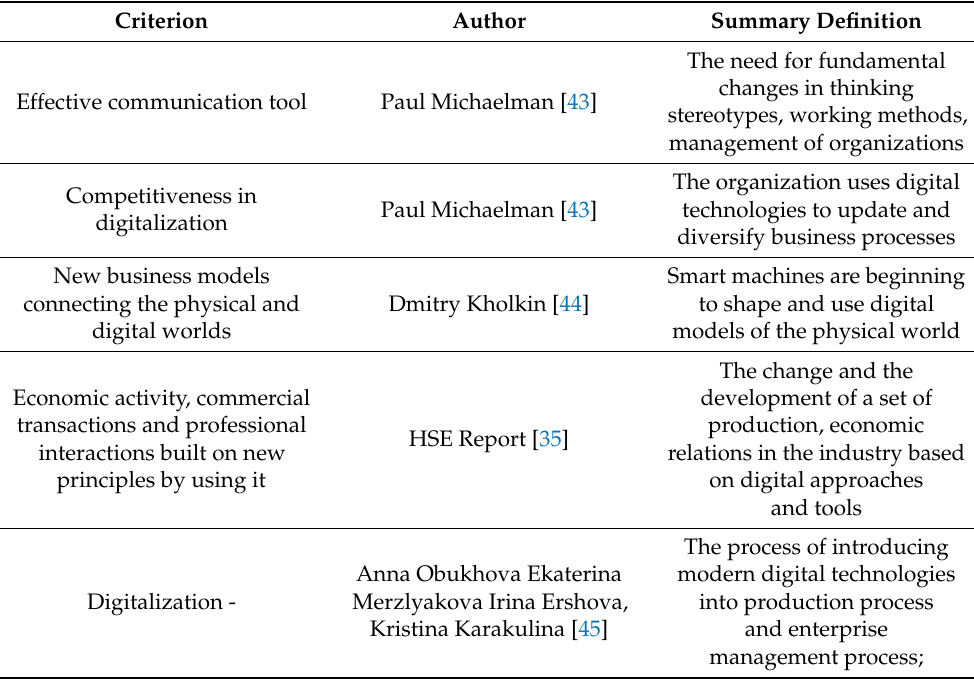
Table 3. The essence of digitalization in the energy sector according to the criteria identified by the authors of the article (developed by the